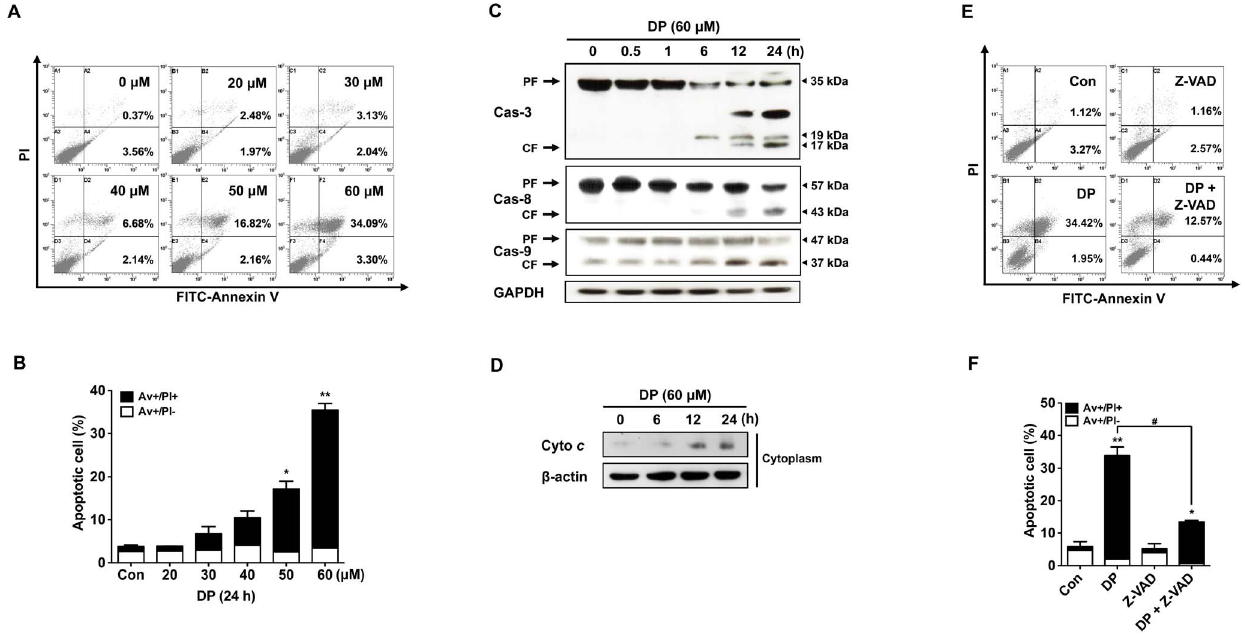
Figure 2. DP induced both extrinsic and intrinsic apoptosis pathway in MG-63 cells . After treatment with various concentration of dendropanoxide (DP) for 24 h and then apoptotic cells were detected by Annexin V and PI stained (A) and quantitative analysis of Av + /PI- (early apoptosis) and Av + /PI + (late apoptosis) cells (B) by flow cytometry. Cells were treated with 60 m M DP for different times and then analyzed by immunoblotting with an antibody against caspase-3 (Cas-3), caspase-8 (Cas-8) and caspase-9 (Cas-9) (C). An accumulation of cytochrome c (Cyto c ) in the cytosolic fraction was analyzed by immunoblotting (D). Cells were treated with 60 m M DP for 24 h in the presence or absence of 40 m M Z-VAD- FMK, the percentage of apoptotic cells were detected by flow cytometry for Annexin V/PI staining (E). Quantitative determination of Av + /PI- and Av + / PI + MG-63 cells by flow cytomertry (F). Data were expressed as the mean 6 SEM of repeated three times experiments. * P , 0.05 and ** P , 0.01 compare with control; # P , 0.05 compared with DP.